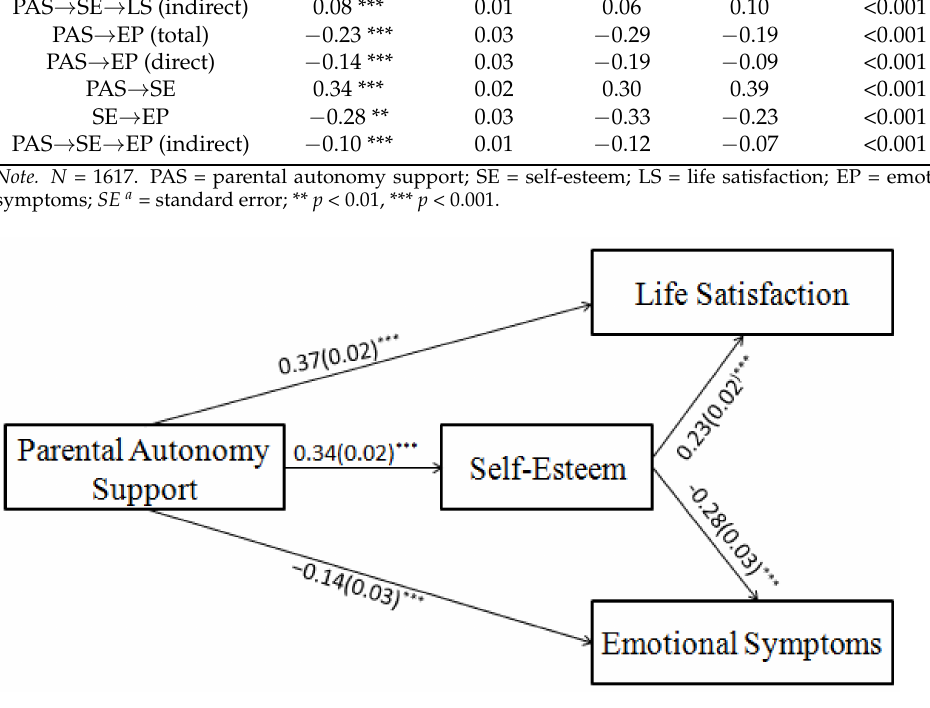
Figure 2. Mediation model for Study 1. Note. N = 1617. Standardized path coefficients and standard errors (inside the brackets); *** p <